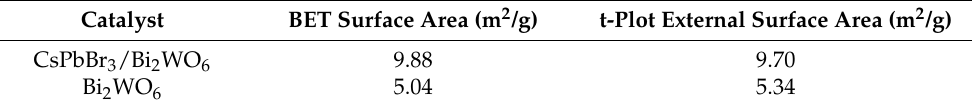
Figure 3. SEM images of ( a ) Bi 2 WO 6 and ( b ) CsPbBr 3 /Bi 2 WO 6 photocatalysts. Table 3. The specific surface of Bi 2 WO 6 and CsPbBr 3 /Bi 2 WO 6 .